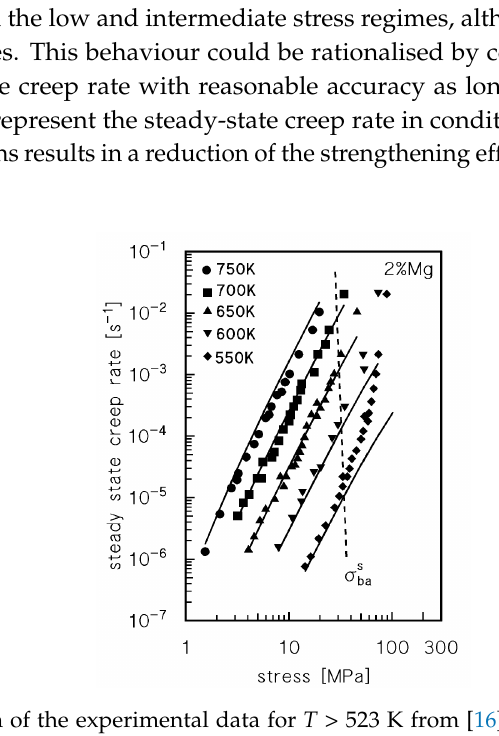
Figure 5. Description of the experimental data for T > 523 K from [16] by Equations (10) and (11), where the drag stress σ ss is obtained from Equations (19) and